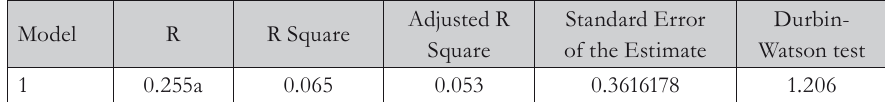
Tab. 4 - Model summary. Source: Data